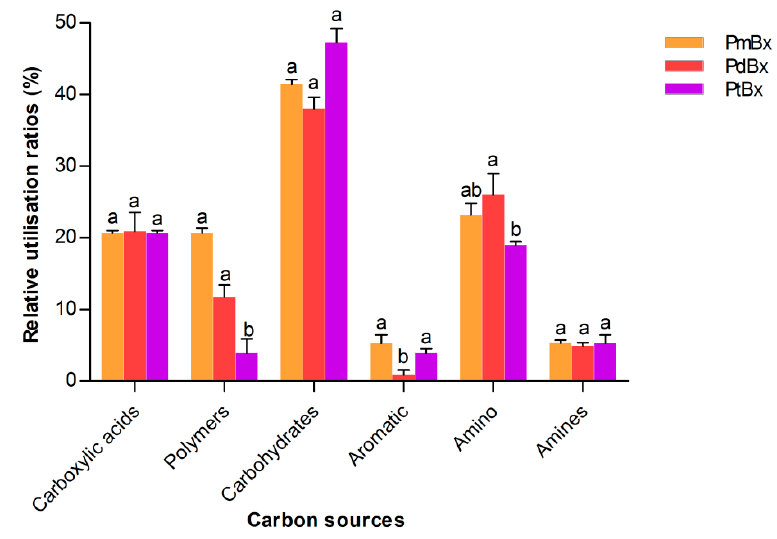
Figure 3. Relative utilization ratios of six groups of carbon sources by the endo-bacteria from Bursaphelenchus xylophilus. The bar indicates standard errors, and any two samples with a common letter are not significantly different ( p > 0.05).